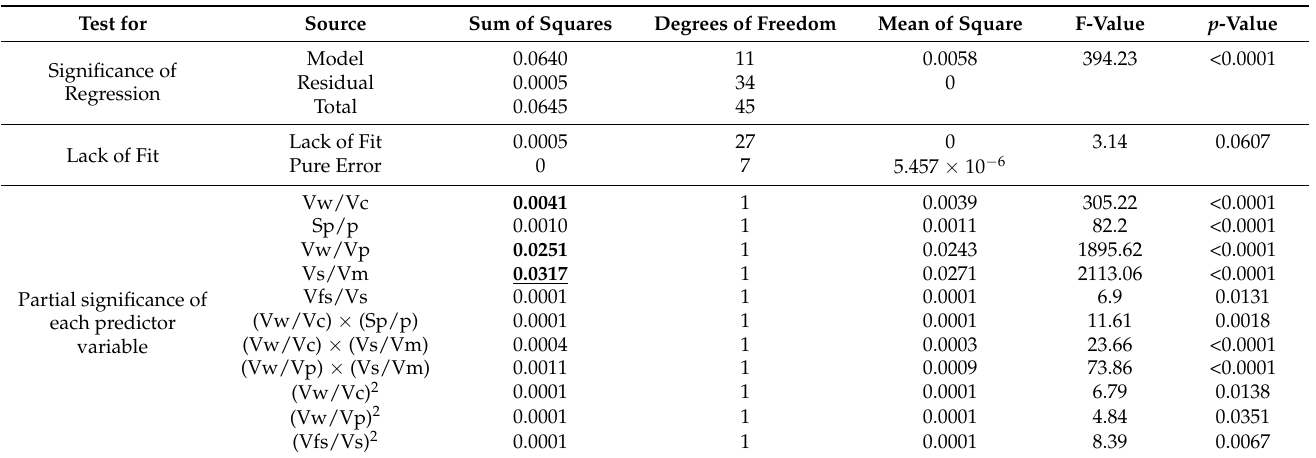
Table 7. ANOVA results for the T-funnel response.